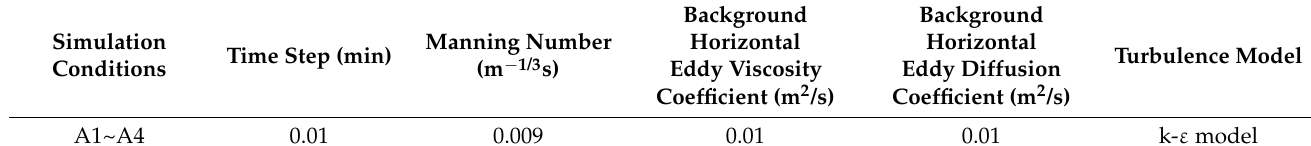
Table 2. Computational parameters of the three-dimensional numerical reservoir model.